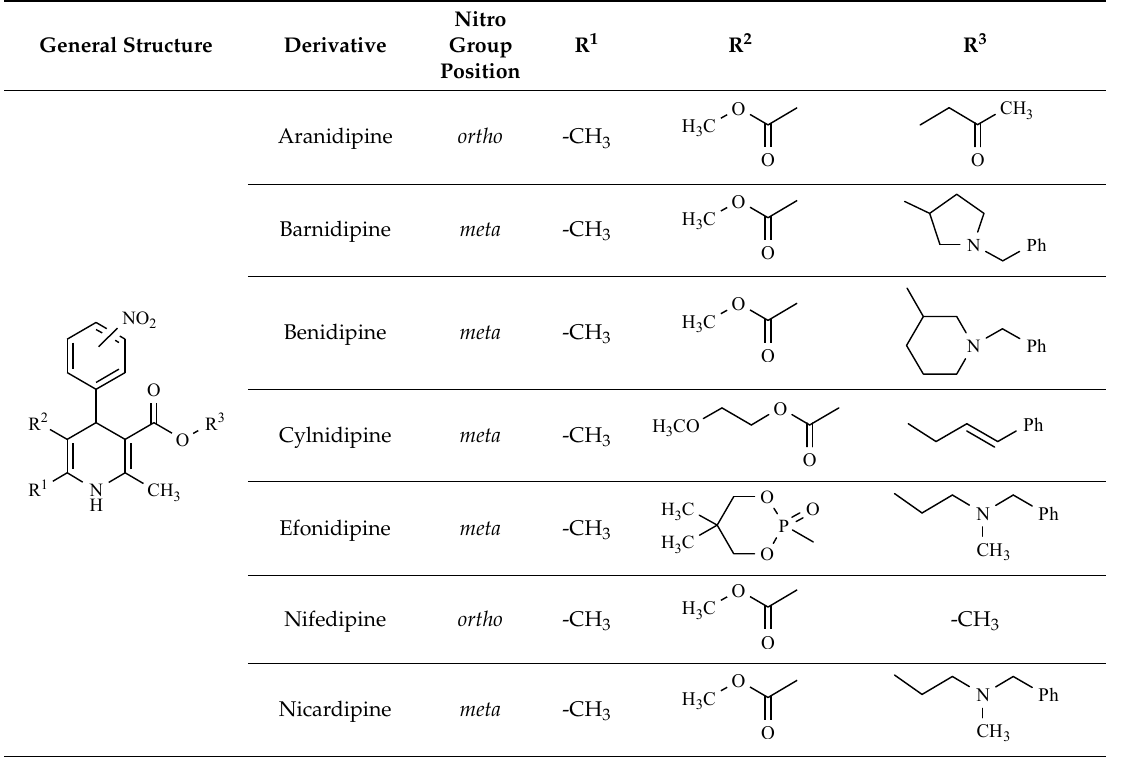
Table 1. Nifedipine derivatives.